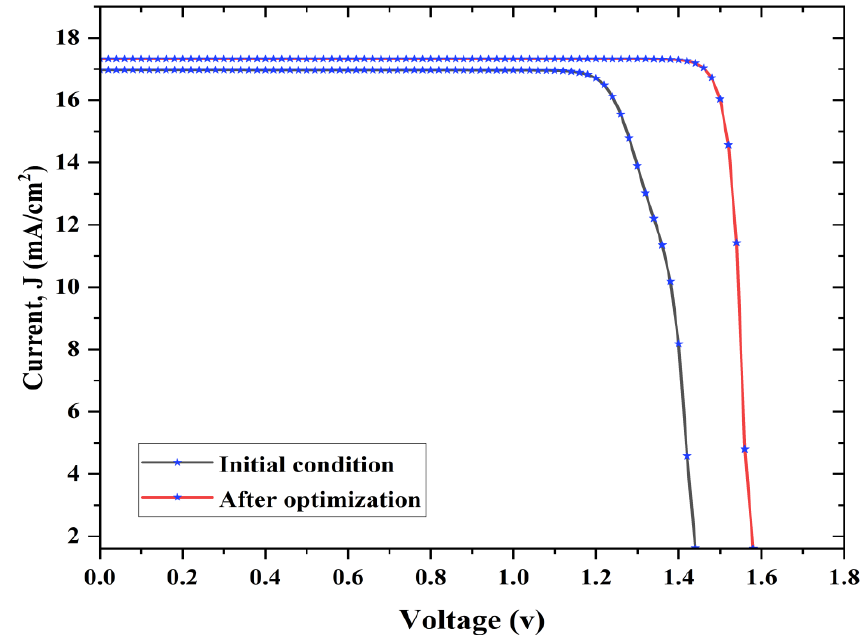
Figure 14. Comparison of J-V curves of the initial and optimized models.